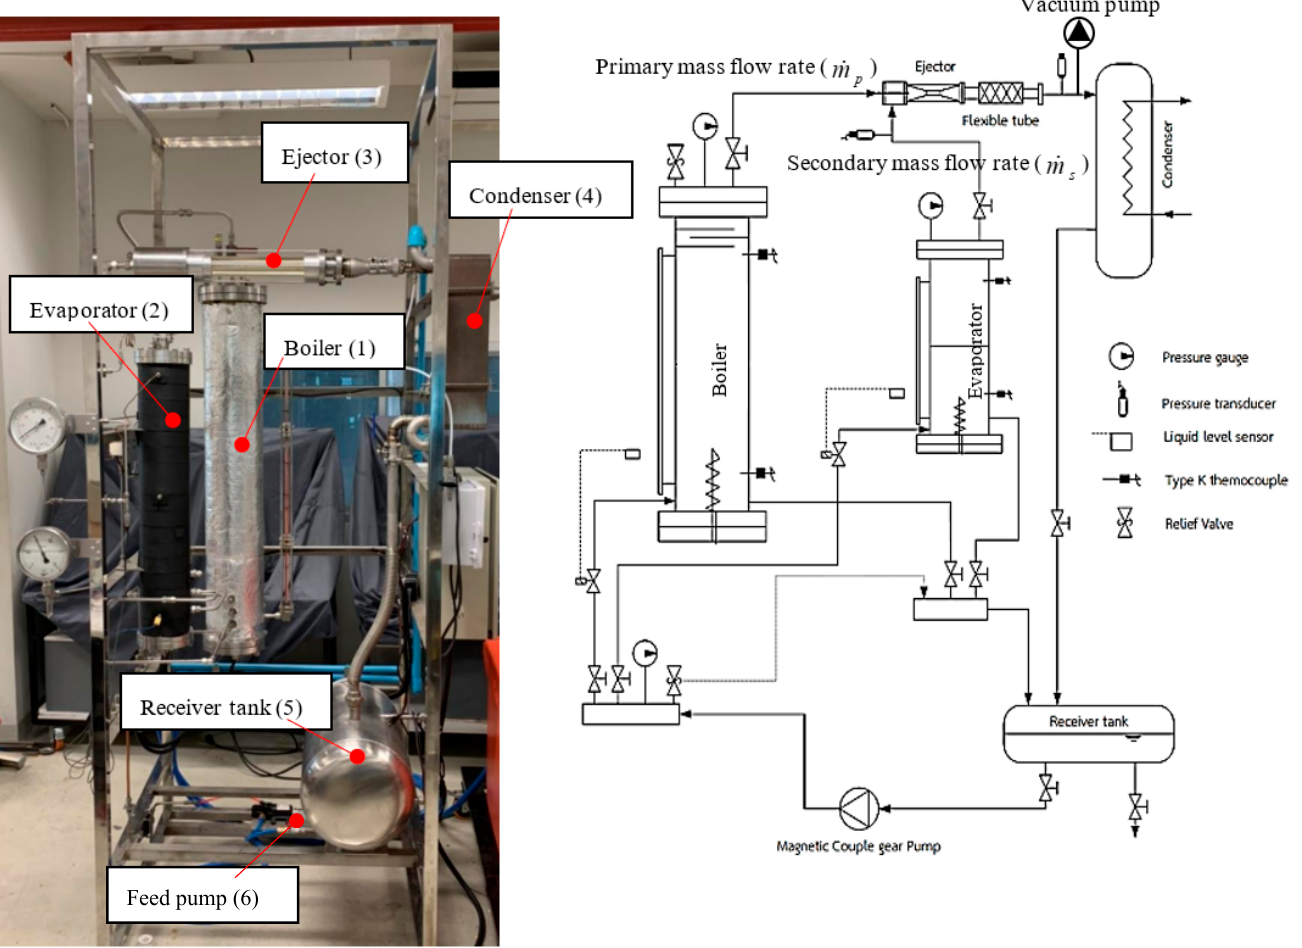
Figure 1. The picture and schematic view of a steam ejector refrigerator test bench.